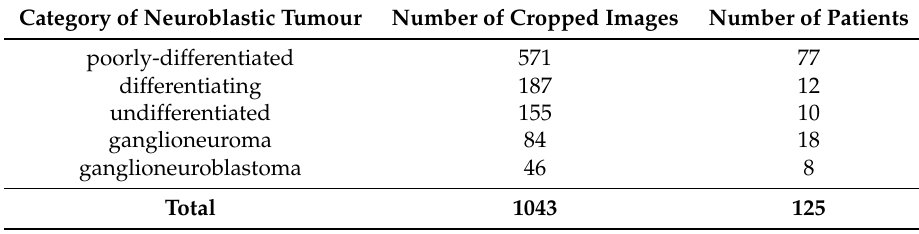
Table 1. Number of different categories of neuroblastic tumour cropped